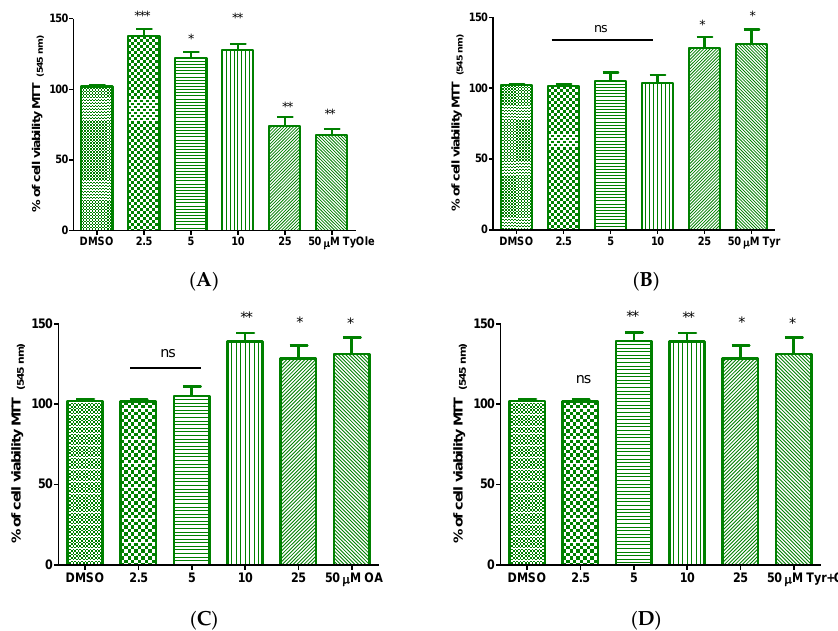
highlighted by white arrows. In Figure 4, an increased nuclear lobe formation in keratino- Figure 3. Human keratinocyte cell viability upon 24 h incubation with different concentrations Figure 3. Human keratinocyte cell viability upon 24 h incubation with different concentrations cytes cultured with TyOle (panel E) compared to the vehicle alone (panel B) is shown and (range 2.5 – 50 µM) of tyrosyl oleate (TyOle) ( A ), tyrosol (Tyr) ( B ), oleic acid (OA) ( C ), and combi- (range 2.5–50 µ M) of tyrosyl oleate (TyOle) ( A ), tyrosol (Tyr) ( B ), oleic acid (OA) ( C ), and combination highlighted by white arrows. Merged images of both conditions are shown in Figure 4C,F, nation of Tyr and OA ( D ), (* p < 0.05; ** p < 0.01; *** p < 0.001). of Tyr and OA ( D ), (* p < 0.05; ** p < 0.01; *** p < 0.001). respectively. Moreover, we also investigated the possibility that TyOle could modulate